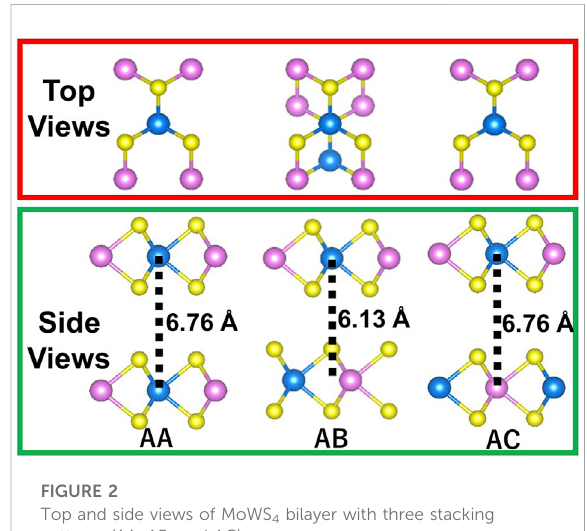
FIGURE 2 Top and side views of MoWS 4 bilayer with three stacking patterns (AA, AB, and